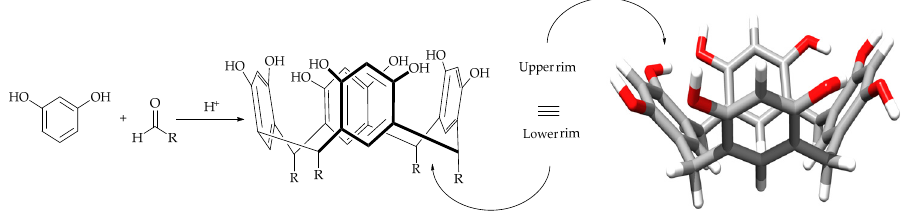
Scheme 4. General scheme for the synthesis of resorcinarene derivatives.